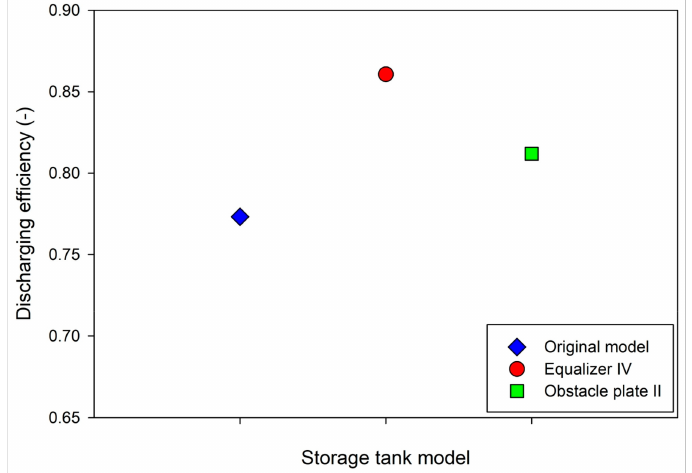
Figure 26. Discharging efficiencies of the equalizer IV and the obstacle plate II